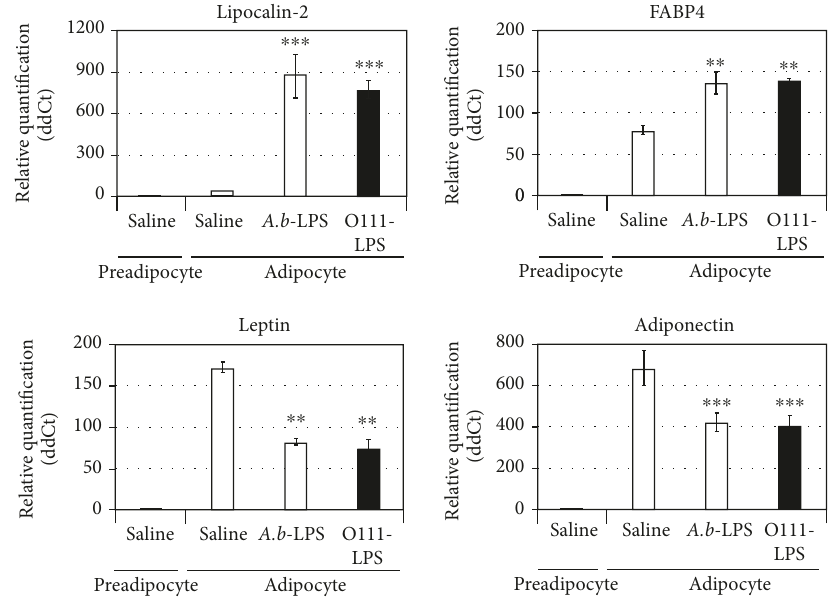
Figure 2: E ff ect of A. baumannii -LPS on adipokine expression in 3T3-L1 adipocytes. Di ff erentiated adipocytes were incubated for 24h with 100ng/mL A. baumannii -LPS (ATCC 19606), 100ng/mL E. coli -LPS (O111:B4), or saline and subjected to real-time PCR analysis to determine the mRNA levels of several adipokines, including lipocalin-2, FABP4, leptin, and adiponectin. Adipokine expression is presented as the ratio of viable adipokine expression in adipocytes treated with the LPS from each of the bacterial strains versus the adipocytes treated with saline. All experiments were performed in triplicates, and the results are shown as mean ± SD. ∗∗ P < 0 01 ; ∗∗∗ P < 0 005 (compared to adipocytes without LPS